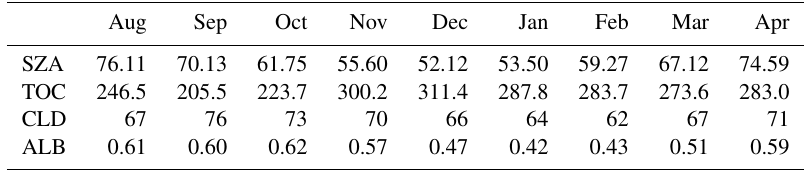
Table 2. Monthly median values of explanatory variables (SZA is solar zenith angle, TOC is total ozone column, CLD is cloud cover, ALB is albedo) at Marambio Base in 2010–2020, which were used to fix the variables in the ANN model runs.